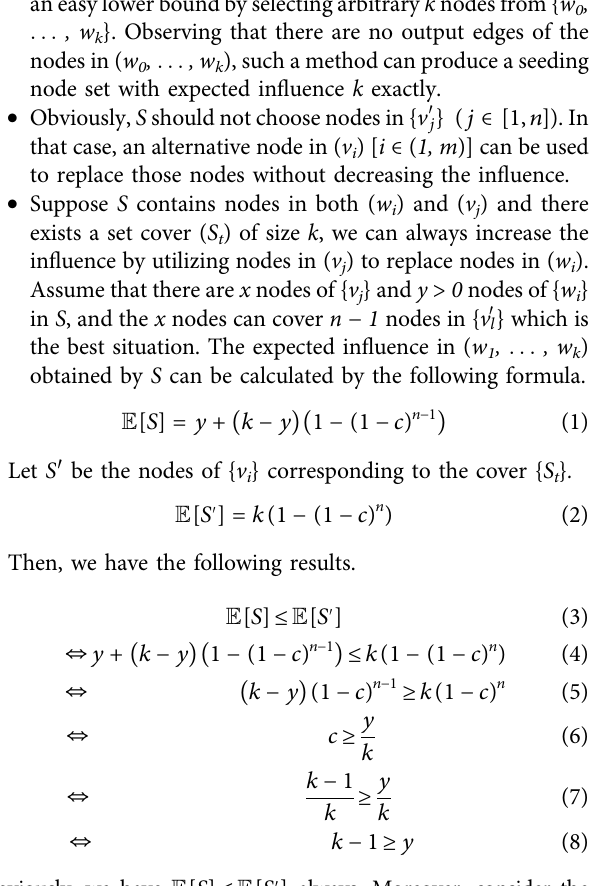
Frontiers in Physics |